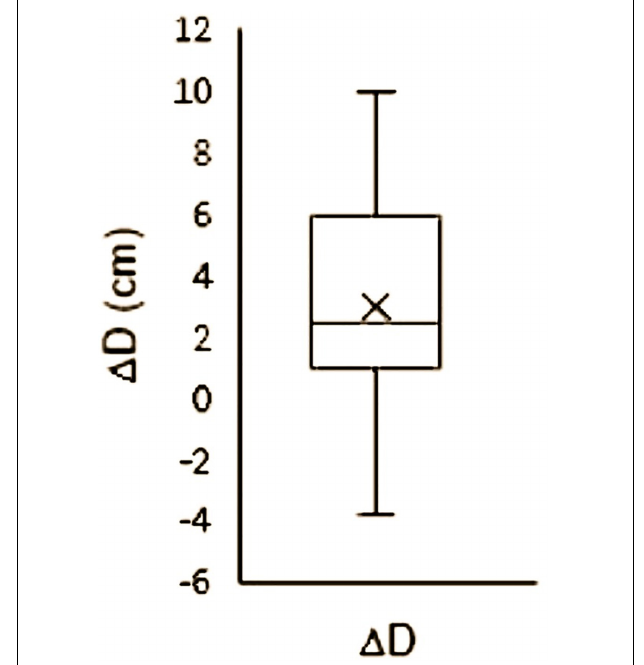
FIGURE 1 | Boxplot for NGVD29 and NAVD88 datum difference for flood-mitigated buildings in Louisiana (2005–2015) with mean ( × symbol), median, and interquartile data